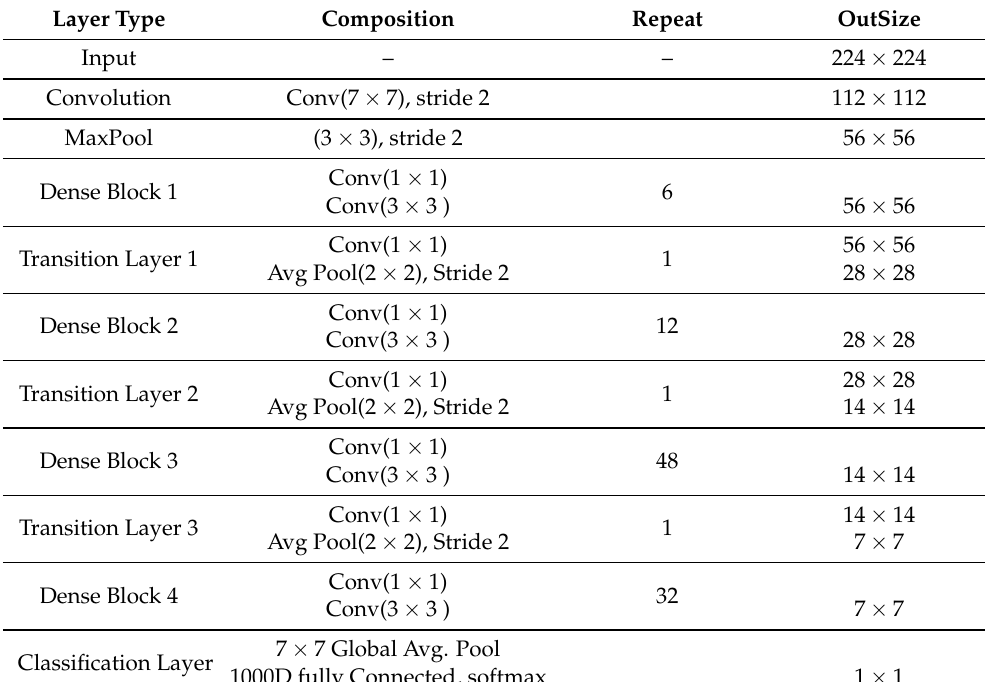
Table 2. DenseNet201 layer